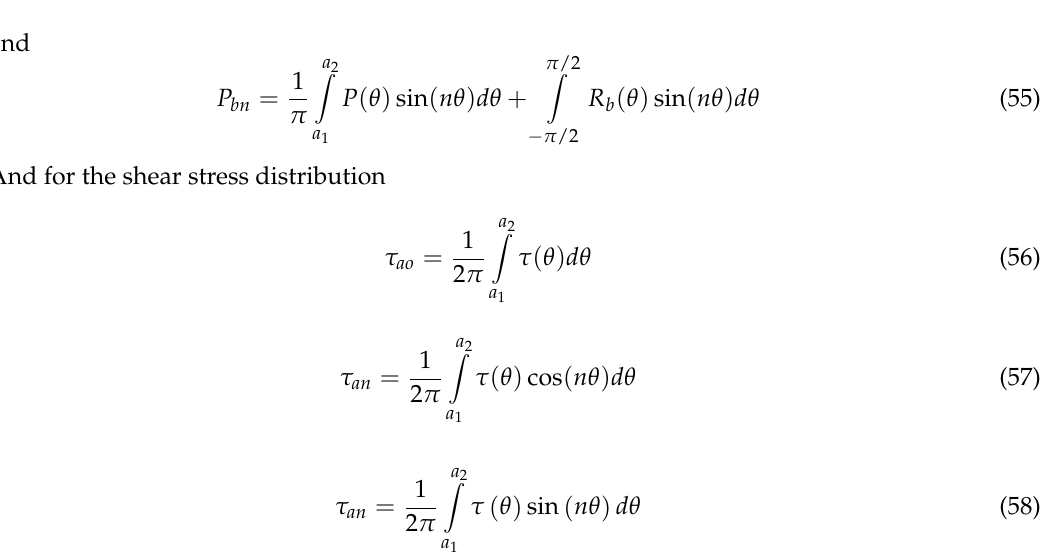
Figure 13. The loading diagram of the rolling die showing the rolling pressure and the interfacial shear stress distributions in addition to the forces that keep the die in equilibrium, for further information see